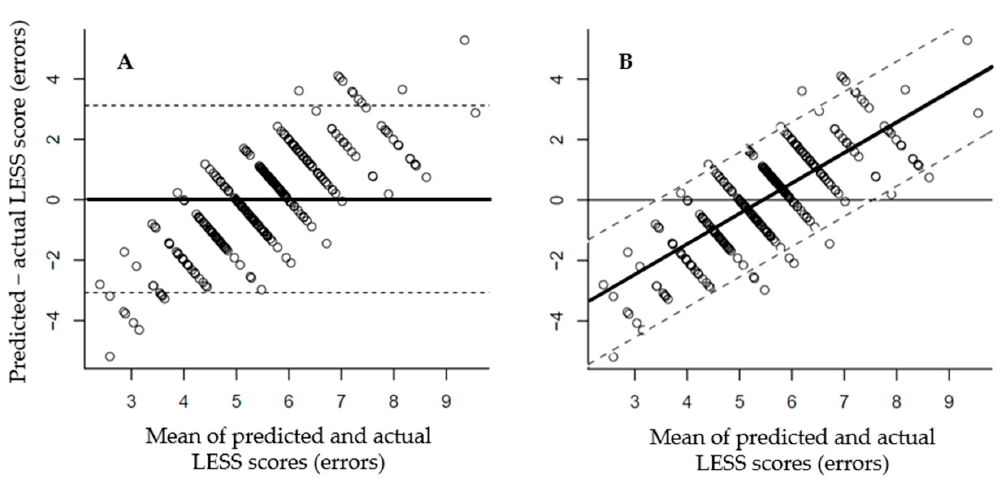
Figure 5. Bland ‐ Altman [21] plots depicting the difference in predicted (automated) and actual (clinical) LESS scores versus the mean scores with ( A ) conventional 95% limits of agreement (mean difference ± 1.96 standard deviation), and ( B ) regression ‐ based limits of agreement (regressed difference between methods on the mean of the two methods ± 2.46 standard deviation of the residual).